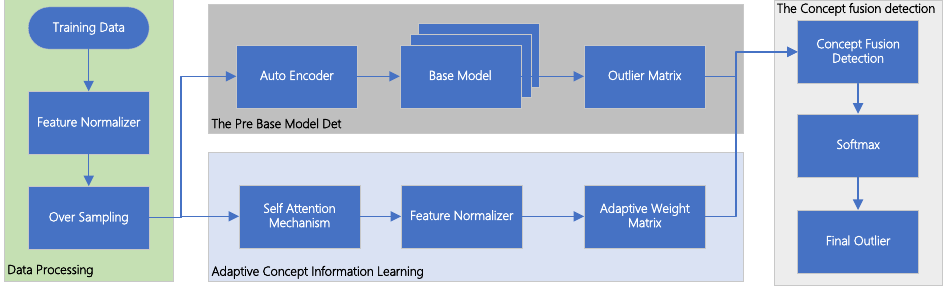
Figure 3. Flow chart of TSMASAM